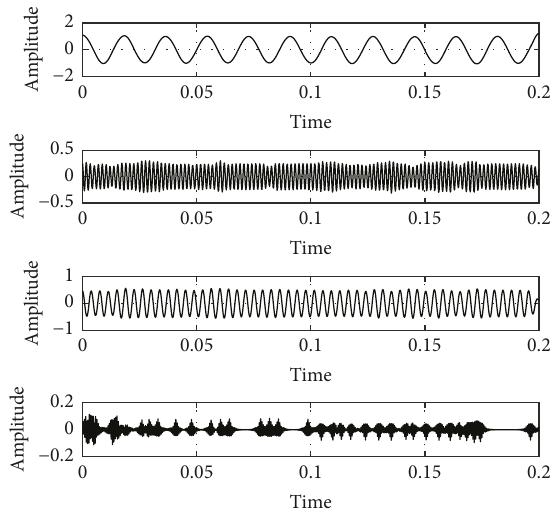
Figure 6: Results of signal decomposition by improved VMD.